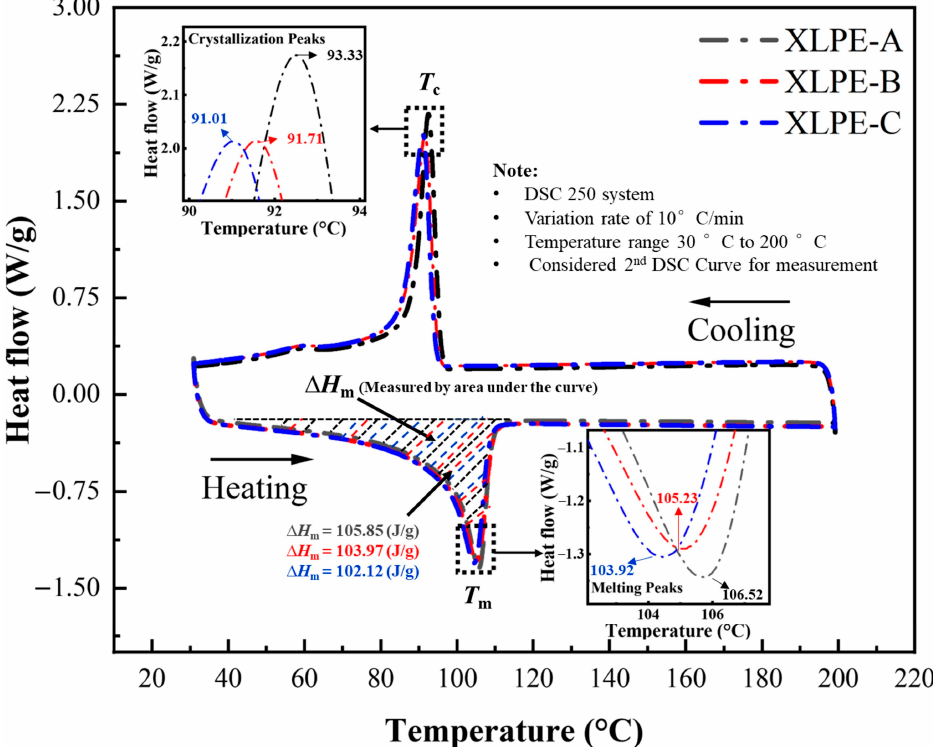
Figure 1. Determination of crystallization parameters of XLPE prepared with DCP content of 1.4% (XLPE-A), 1.7% (XLPE-B) and 2% (XLPE-C). The insets of this figure indicate the melting peaks ( T m ) and crystallization peaks ( T c ) of XLPE-A, XLPE-B and XLPE-C. The melting enthalpy ( ∆ H m ) is measured by evaluating the area under the curves. Table 2. Parameters of crystallization obtained from DSC